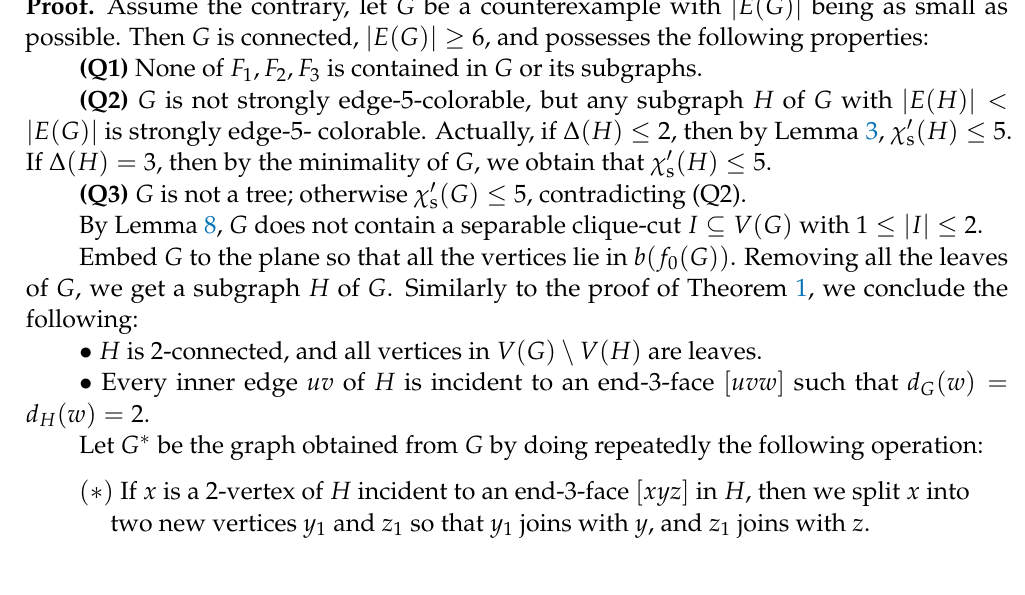
Figure 2. G ∗ is obtained from G by carrying out ( ∗ ) , and G ∗ is a subgraph of S 4 Noting that 3 k − 4 ≥ max { 2 k , (cid:100) 2.5 k − 2 (cid:101)} , we deduce by Lemmas 5 and 7 that χ (cid:48) ) ≤ 3 k − 4 = 3 ∆ − 4. This completes the proof of the ( S k ( G ∗ ) ≤ χ (cid:48) χ (cid:48) n s s